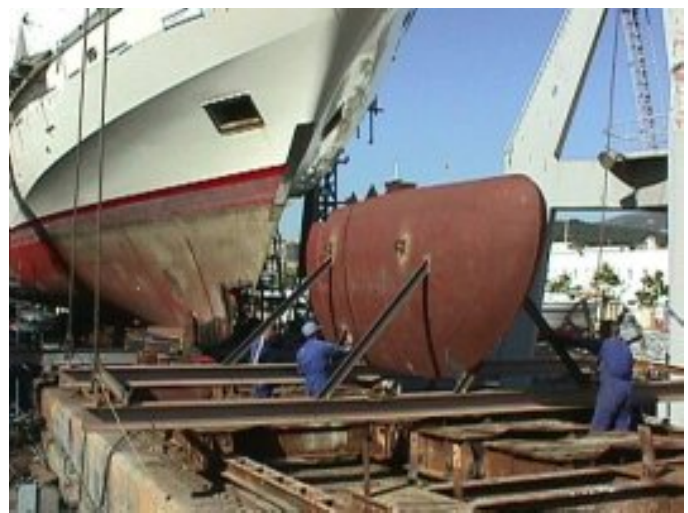
Figure 5. Nesting of a bulb on an existing yacht with conventional